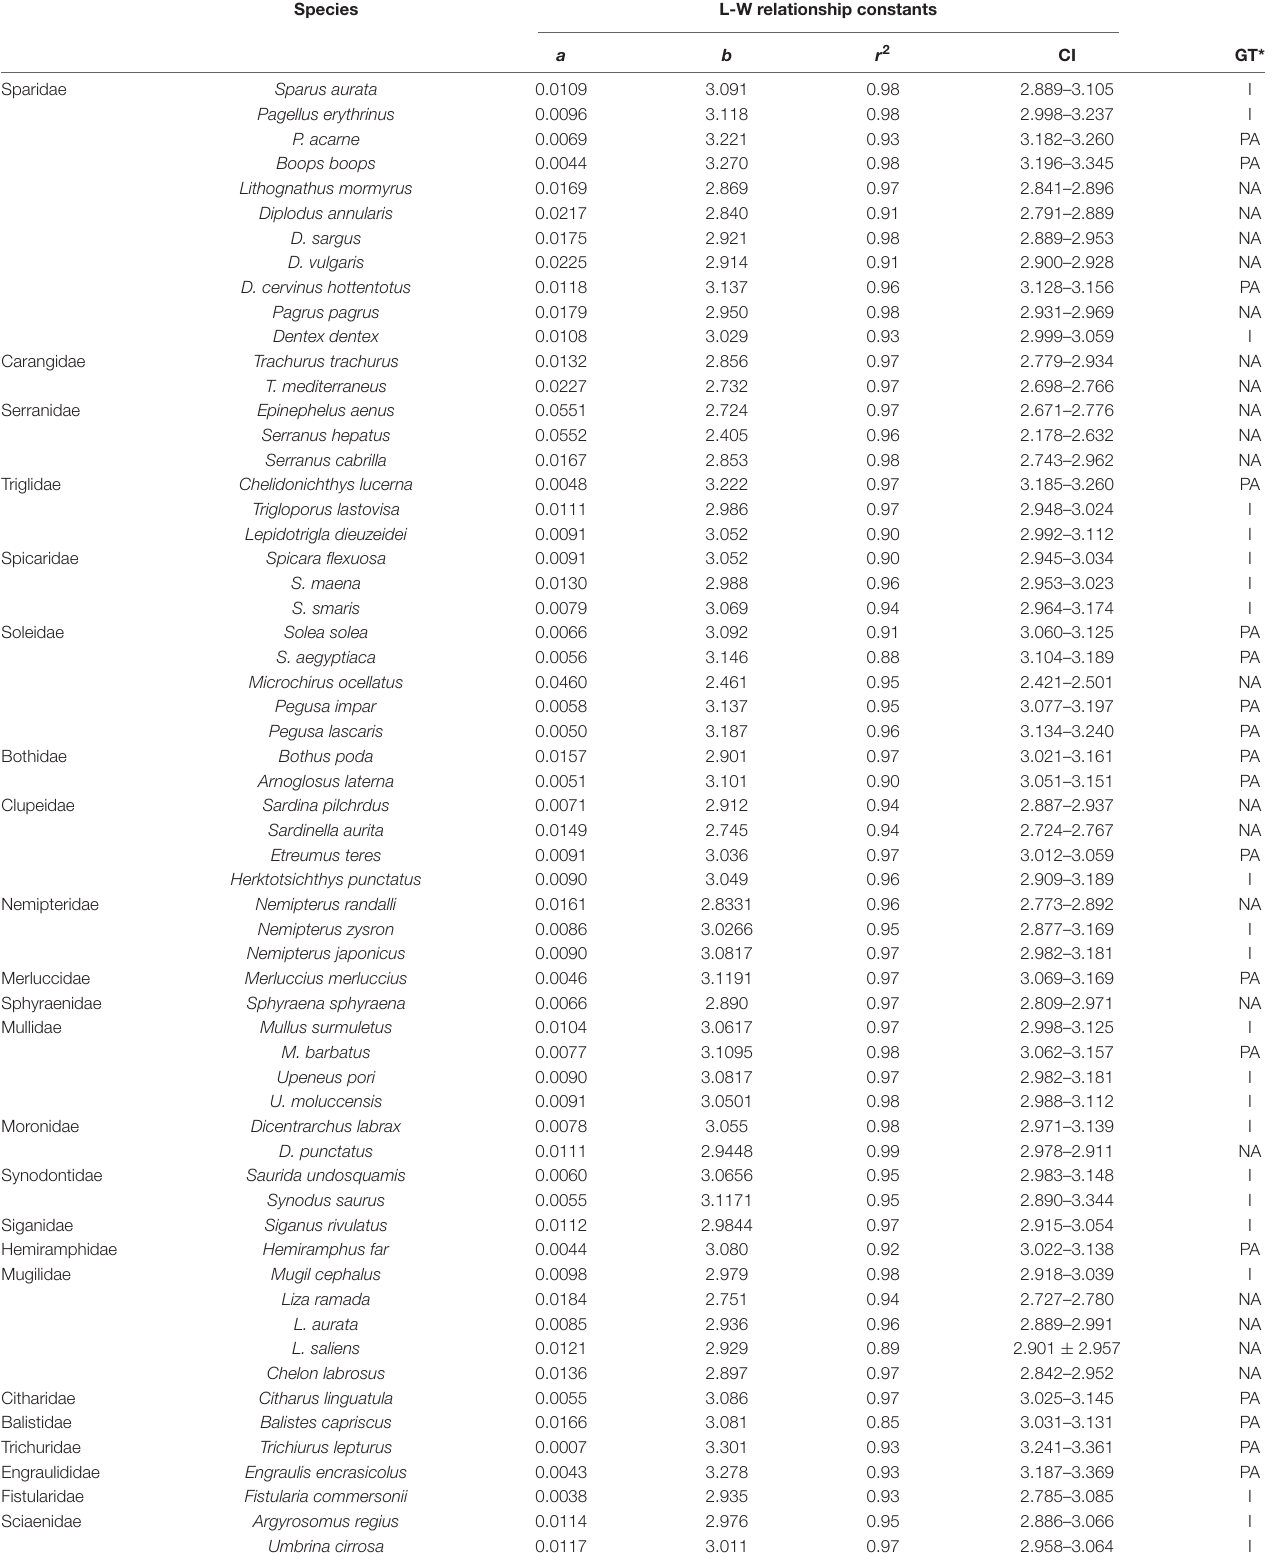
TABLE 2 | Length-weight relationship (LWR), the confidence interval (CI) for b -value, and growth type (GT) for 60 fish species caught from the GSA 26.